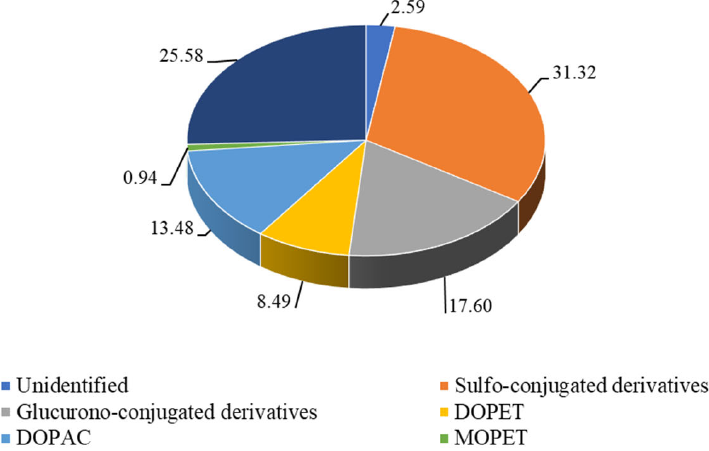
Figure 4. Cumulative percentage (24 h) of metabolites present in urine after oral dose (15 mg, 97.3 μ mole) of hydroxytyrosol (3,4 ‐ dihydroxy ‐ phenylethanol, DOPET). Results were expressed as mean relative area percentage (%) with respect to all identified and unidentified compounds. DOPAC, 3,4 ‐ dihydroxyphenylacetic acid; DOPET, 3,4 ‐ dihydroxy ‐ phenylethanol; homovanillic acid (HVA);